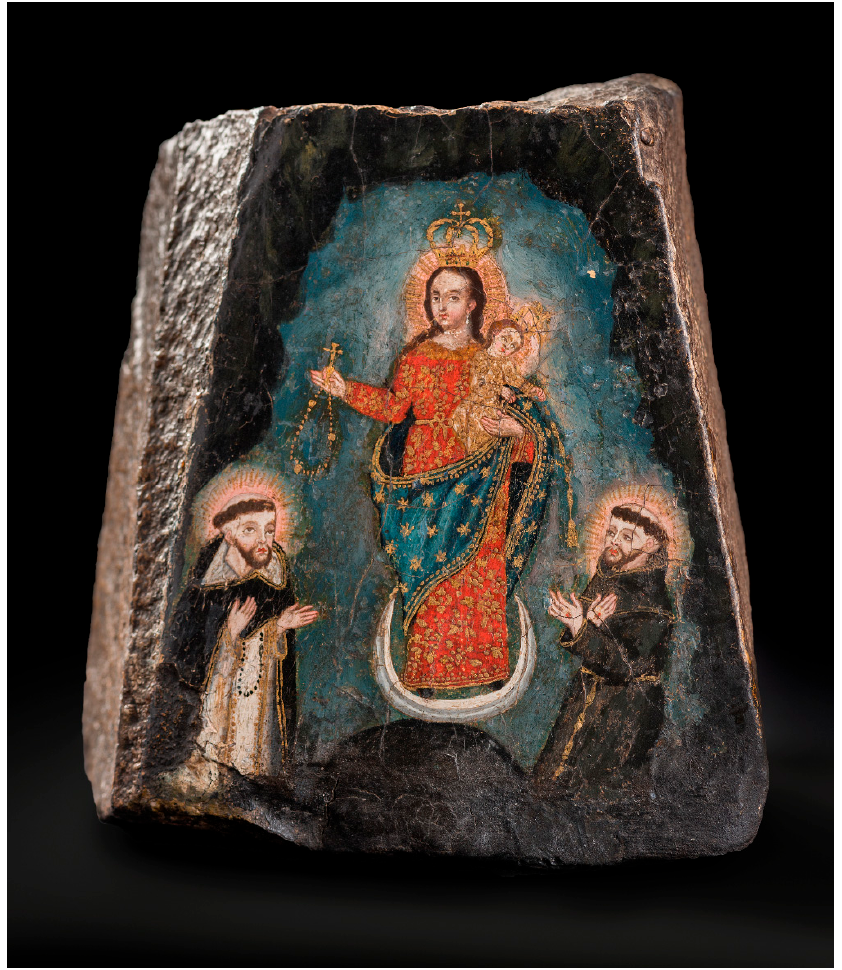
Figure 3. Our Lady of Las Lajas; oil on stone, eighteenth century; Museo Fray Pedro Bedón; Quito (Photo: Cristoph Hirtz, with permission).